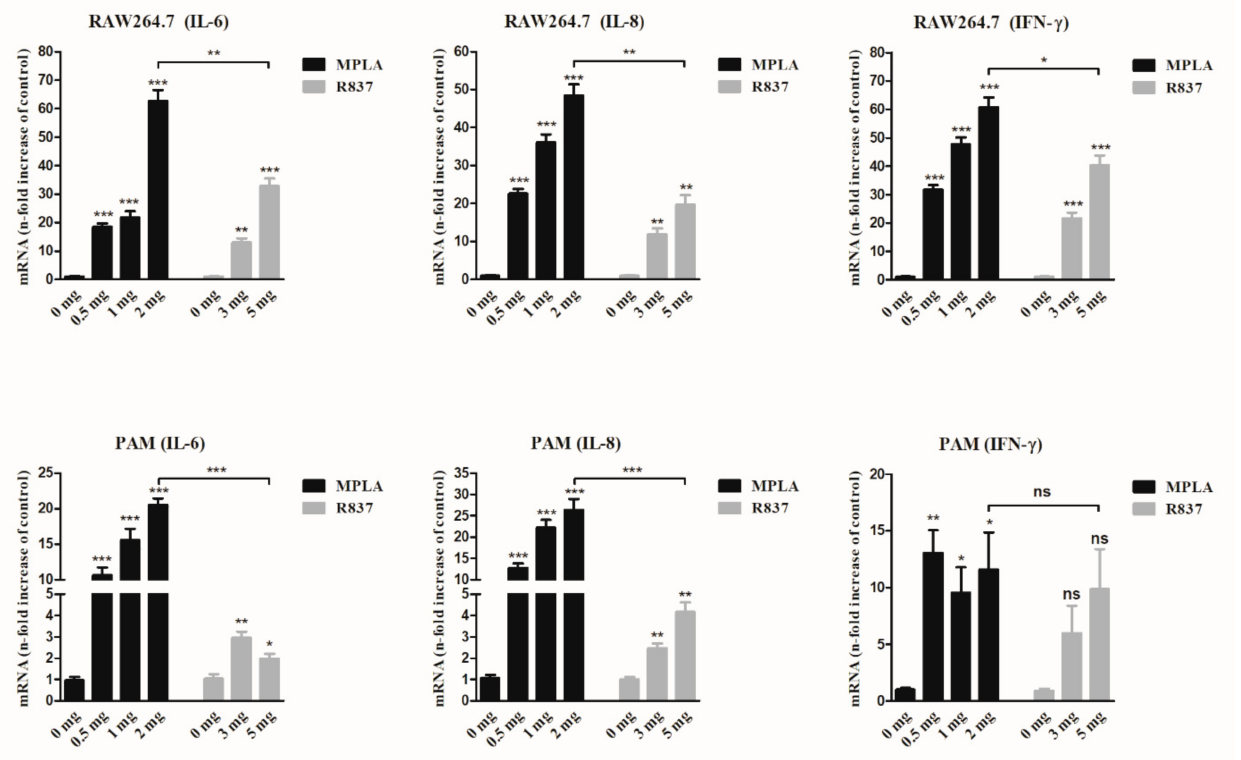
Figure 2. MPLA- and R837-induced cytokine expression in RAW264.7 and PAM cells. IL-6, IL-8, and IFN- γ levels were measured by qRT-PCR. Untreated cells served as the control. Levels of IL-6, IL-8, and IFN- γ mRNA were normalized to the mRNA levels of the reference gene; they were then expressed as n-fold increases with respect to the untreated cells (0 µ g of MPLA or R837). Kruskal Wallis test followed by Dunn’s post-hoc test was used to compare the results between the different treated groups and controls. *** p < 0.001, ** p < 0.01, * p < 0.05, and ns ( p > 0.05). Error bars represent